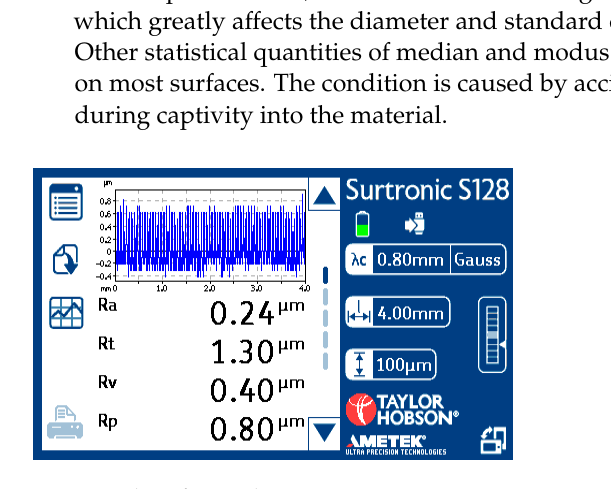
Figure 4. Chart for mode Ra 0.24. Table 5. Component 2.